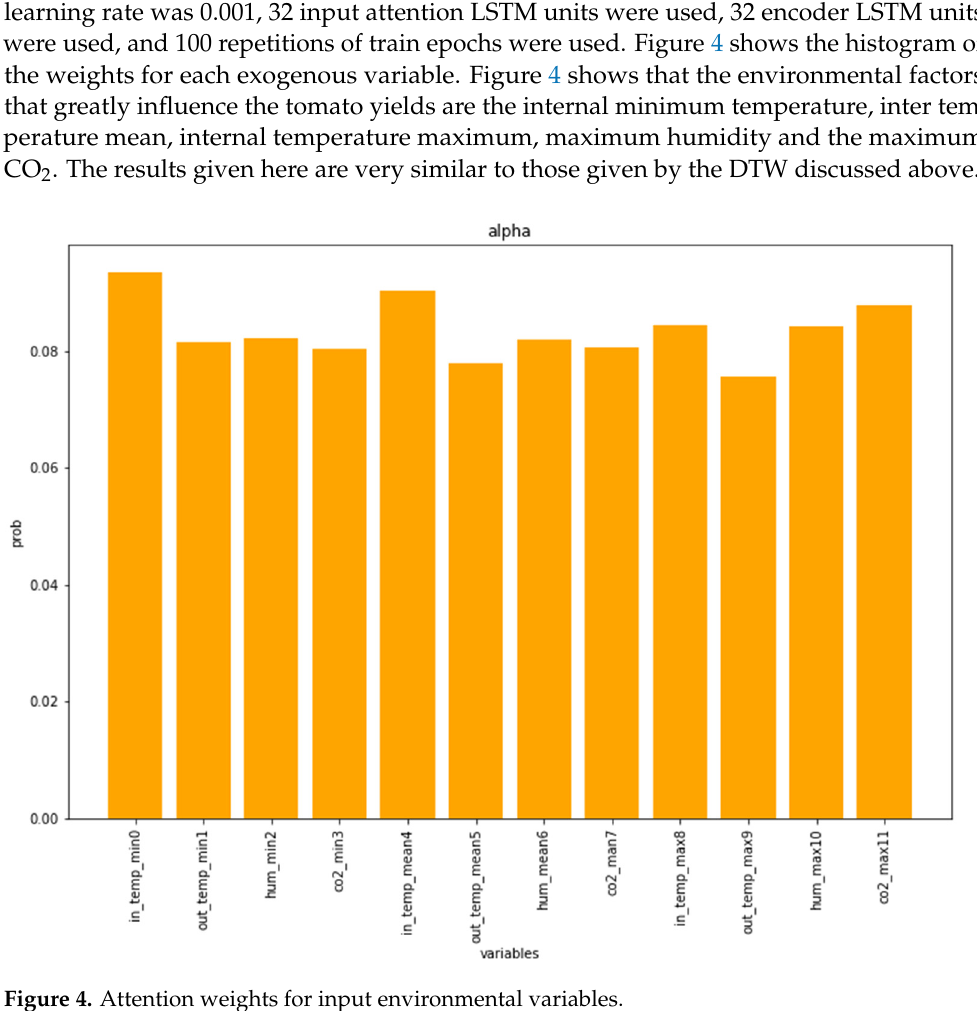
Figure 5. Scatterplot between predicted values and actual values.